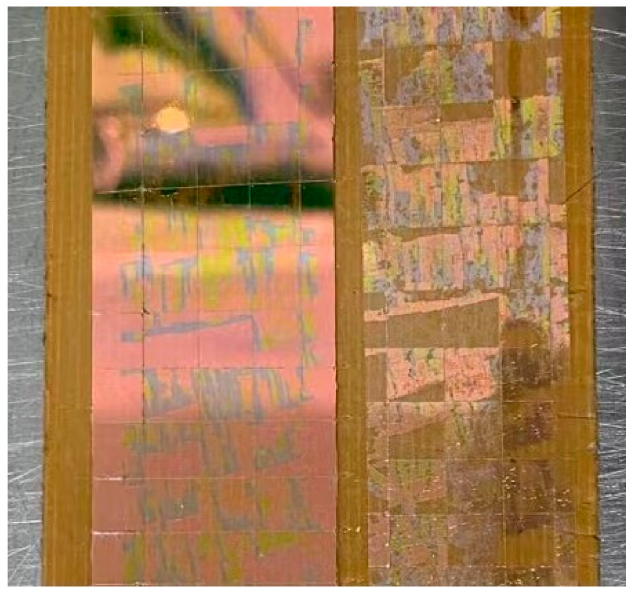
Figure 3. Peeling